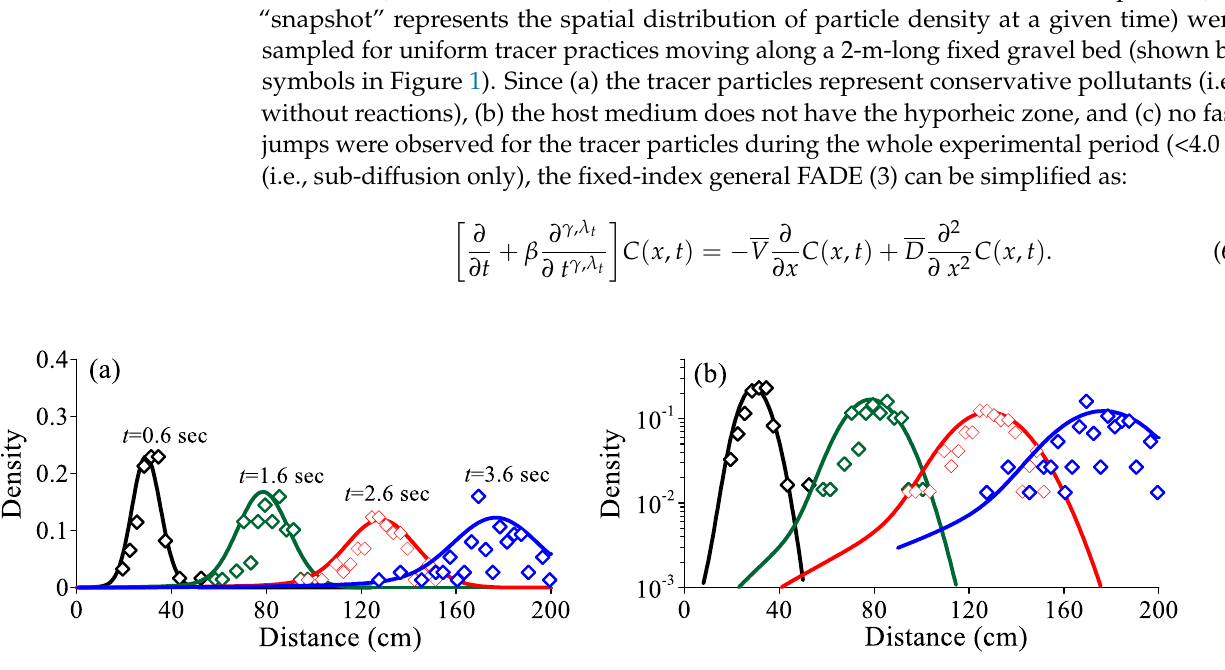
Figure 1. Application 1: ( a ) The measured (symbols, from Martin et al. [46]) versus the best-fit snapshots for bedload moving along a fixed gravel bed. ( b ) is the log-log plot of ( a ) to show the tail.